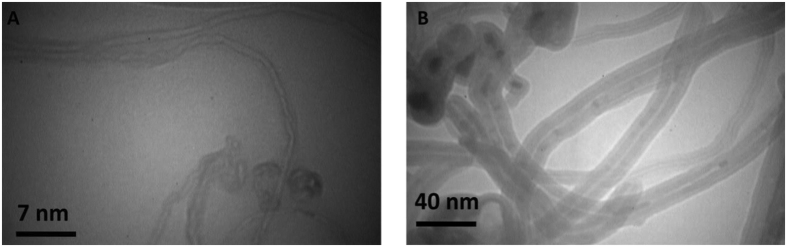
TEM images of CNTs.TEM images of SWCNT (A) and MWCNT (B).